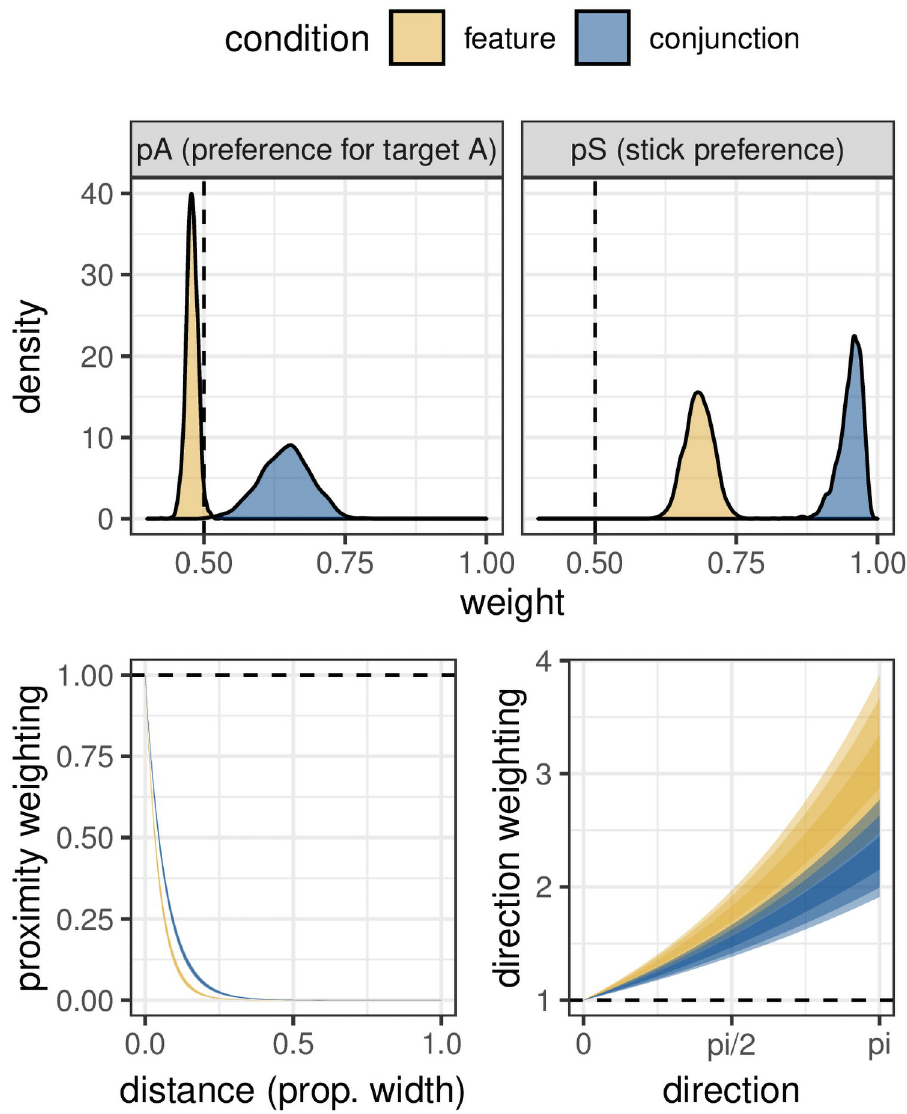
Fig 7. Posterior distributions for our model when trained on data from Clarke et al. (2018). The shaded ribbons for the proximity and direction weighting indicate 53%, 89% and 97% HPDIs. Note that there is a higher weighting for directions closer to pi i.e. completely reversing the direction, indicating negative